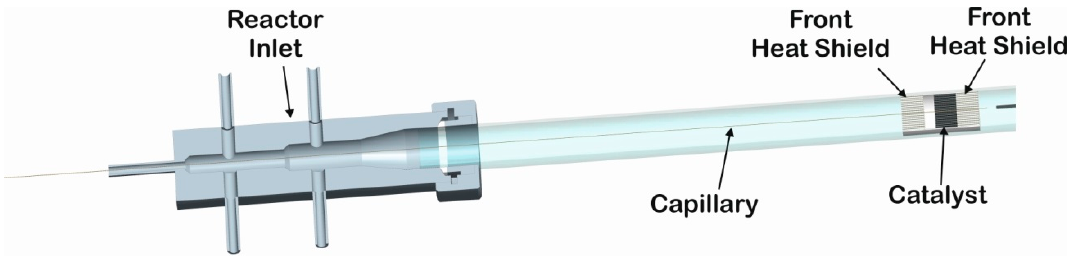
Figure 5. Scheme of the reactor setup with reactor inlet, capillary, front heat shield (FHS), catalyst (CAT), and back heat shield (BHS). The z- axis goes axially through the cylindrical quartz reactor, with z = 0 mm as the catalyst inlet and 10 mm as the catalyst outlet.